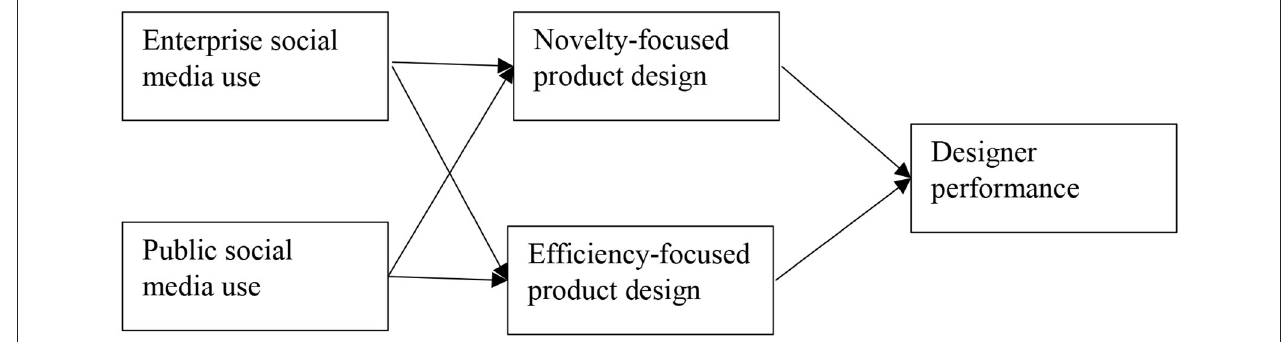
FIGURE 1 | Conceptual model of the